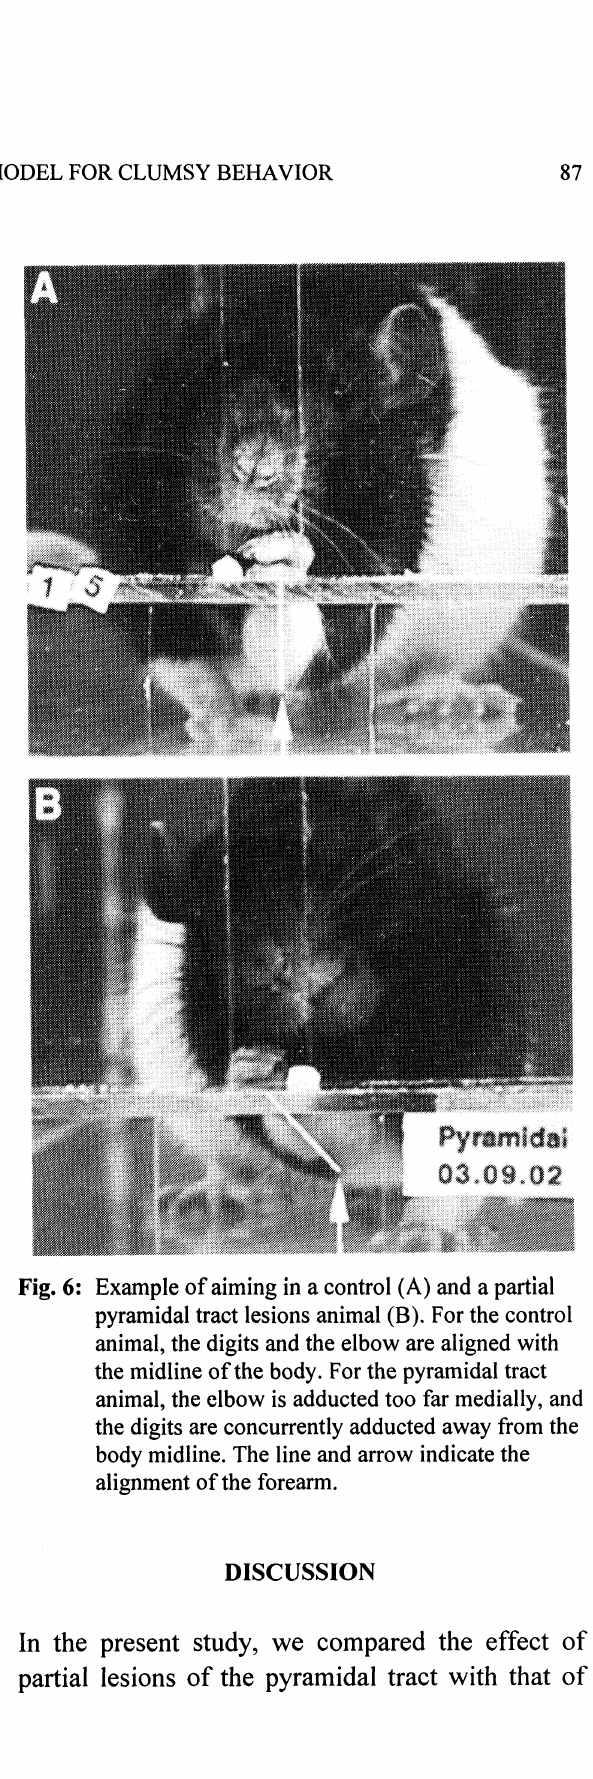
Fig. 6: Example of aiming in a control (A) and a partial pyramidal tract lesions animal (13). For the control animal, the digits and the elbow are aligned with the midline ofthe body. For the pyramidal tract animal, the elbow is adducted too far medially, and the digits are concurrently adducted away from the body midline. The line and arrow indicate the alignment ofthe